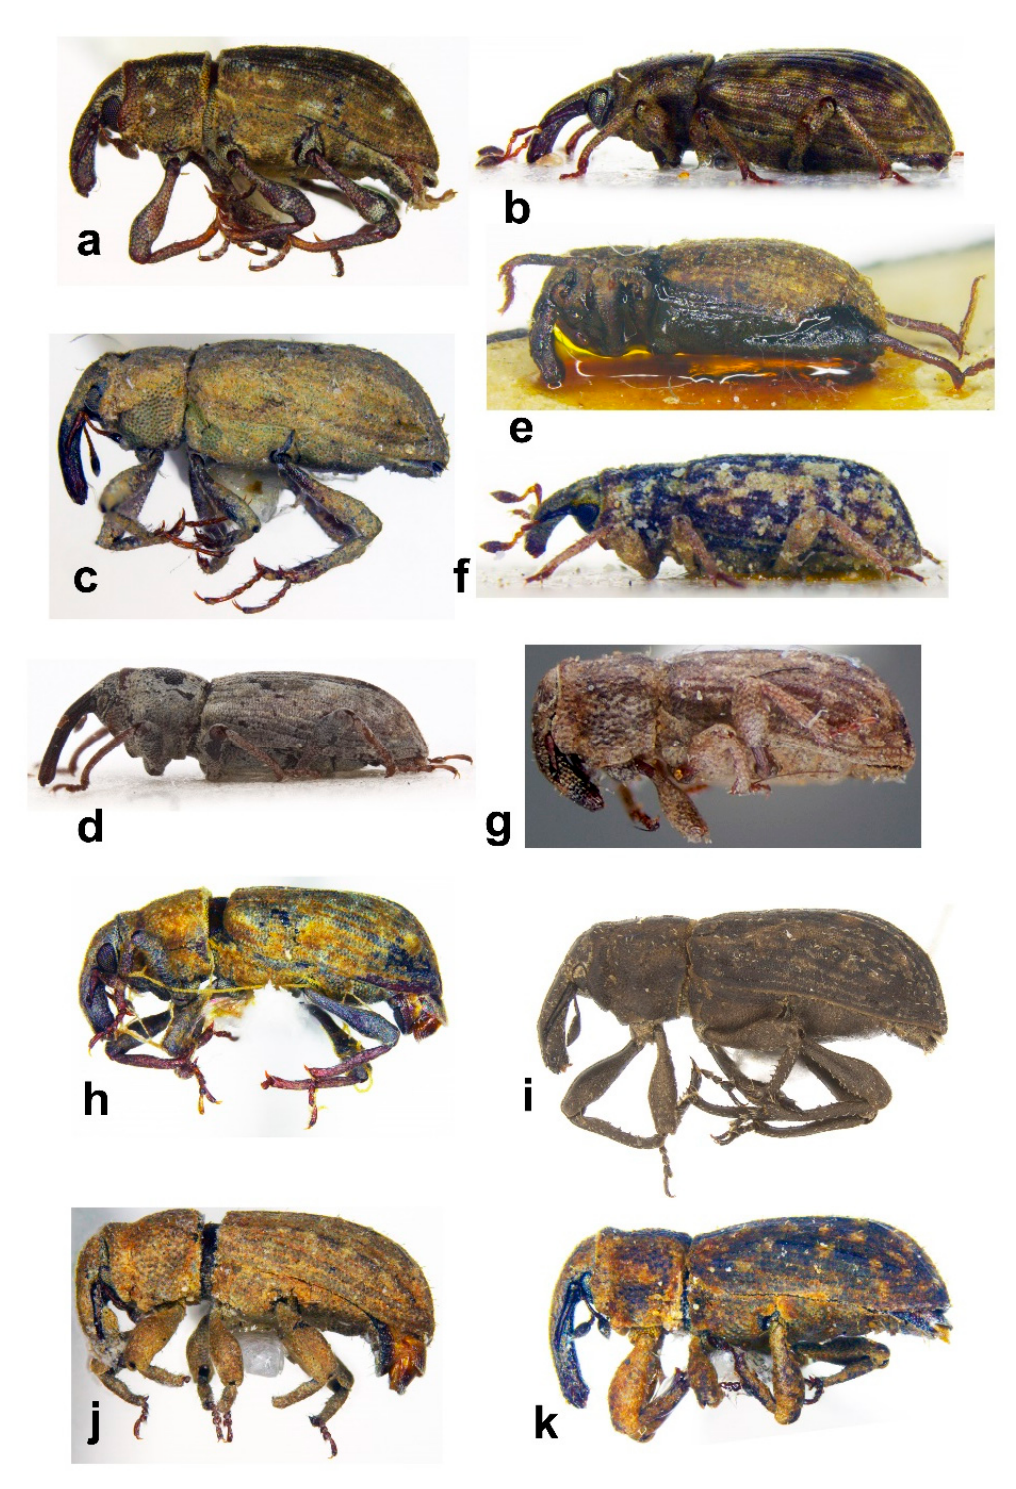
Figure 8. Habitus in lateral view of ( a ) Bagous bagdatensis , male; ( b ) Bagous argillaceus , male; ( c ) Bagous biimpressus , female; ( d ) Bagous mingrelicus , female; ( e ) Bagous lyali , male; ( f ) Bagous subruber , male (IRAQ: Basra, 1.iv.1936, Frey, ZSMU); ( g ) Bagous septemcostatus , male; ( h ) Bagous tempestivus , male; ( i ) Bagous validus , male; ( j ) Bagous libanicus , male; ( k ) B. libanicus , female (not on the same scale).